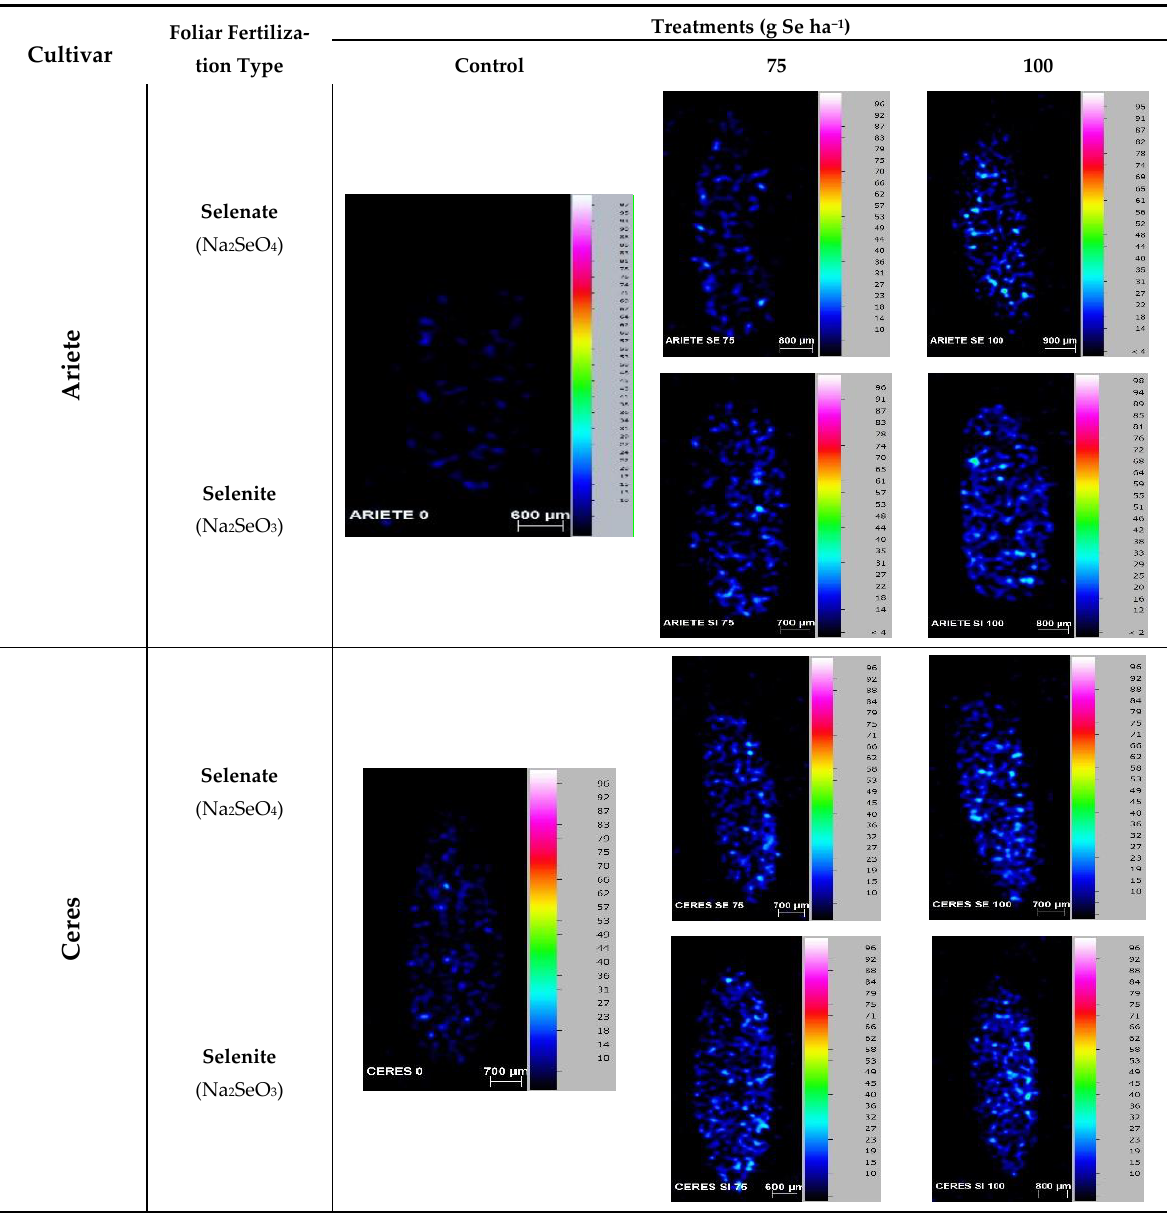
Figure 2. Localization of Se in rice grains of Ariete and Ceres cultivars after foliar spraying with the highest concentrations of sodium selenite and sodium selenate. Control grains did not receive any type of Se enrichment.